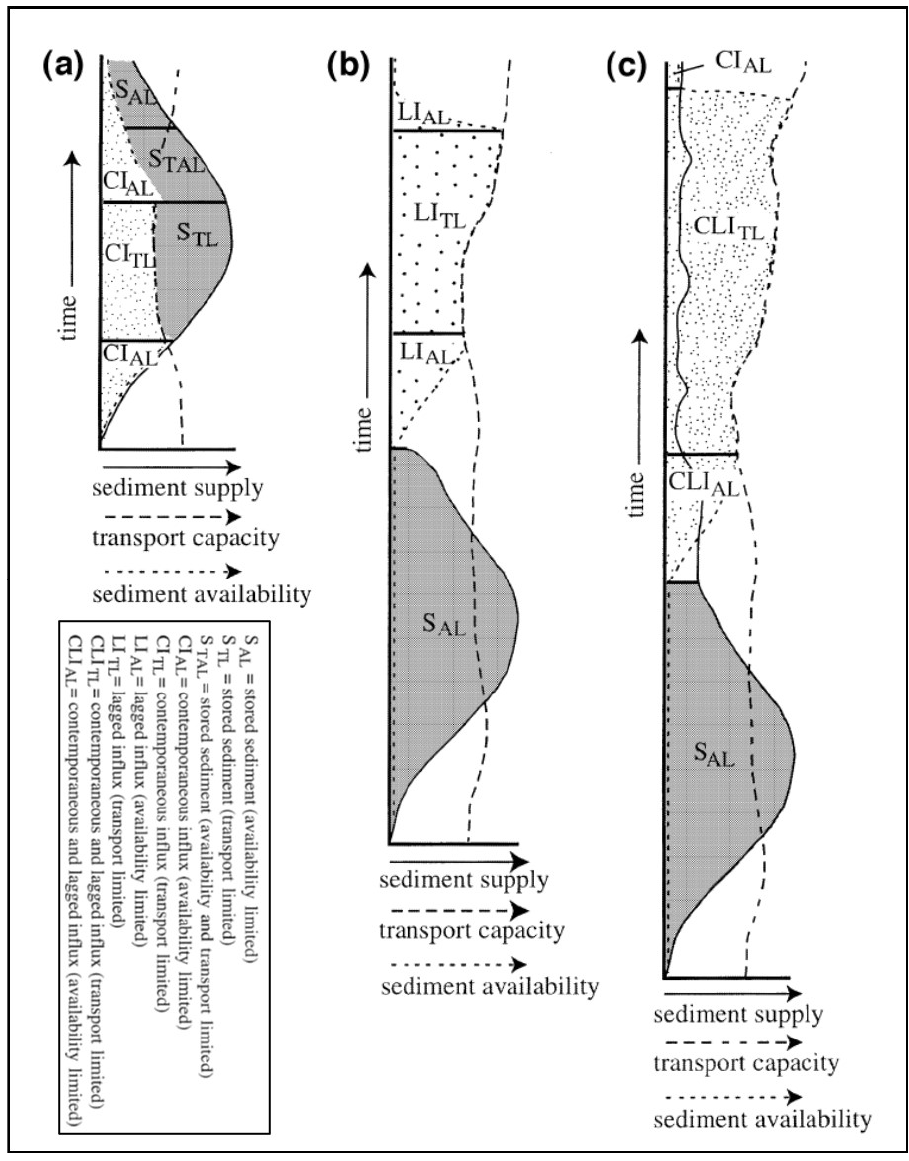
Figure 12. Sand sediment state determined by the plotting of sand sediment supply, sand sediment availability, and the transport capacity of the wind against time (revised [131]). ( a ) Aeolian construc- tion is contemporaneous with the generation of the sand sediment supply. ( b ) Aeolian construction separated in time from an earlier period when the sand sediment supply was generated. ( c ) Aeolian construction sourced by both contemporaneous sand sediment supply and erosion of previously stored sand